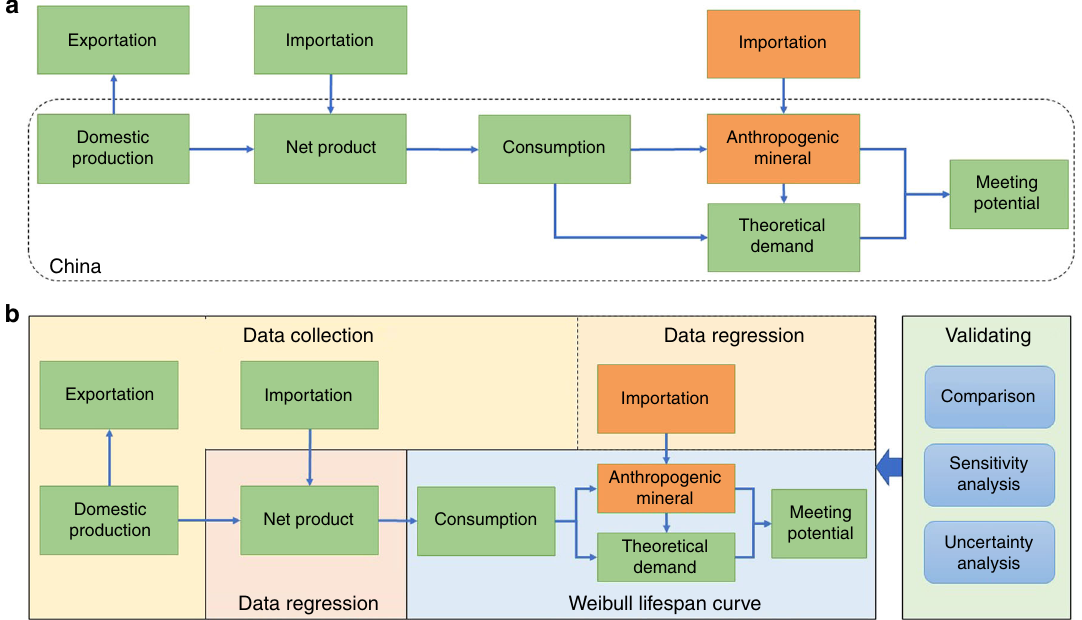
Fig. 1 The designed framework of research methods in this study. a Material fl ow analysis framework for anthropogenic mineral generation and its boundary; Note: green color for product, and orange color for anthropogenic mineral, and dash line indicates the boundary for this study. b Four approaches of data collection, data regression, Weibull lifespan curve, and validating